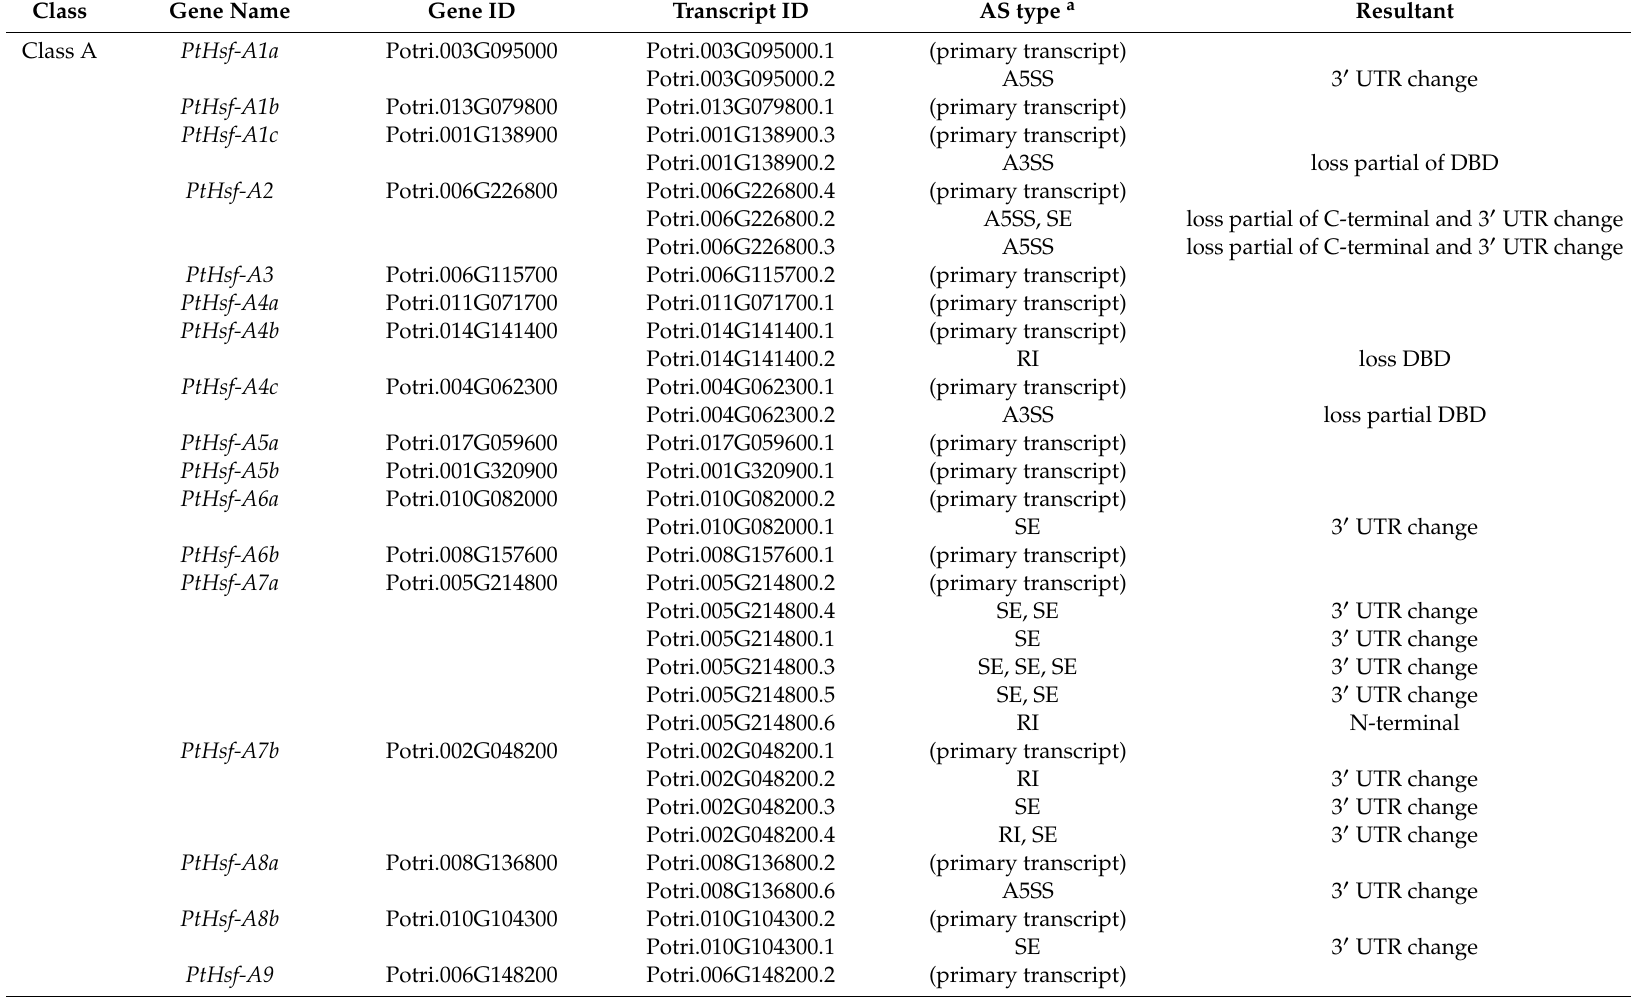
Table 2. The gene list and corresponding transcripts of PtHsfs